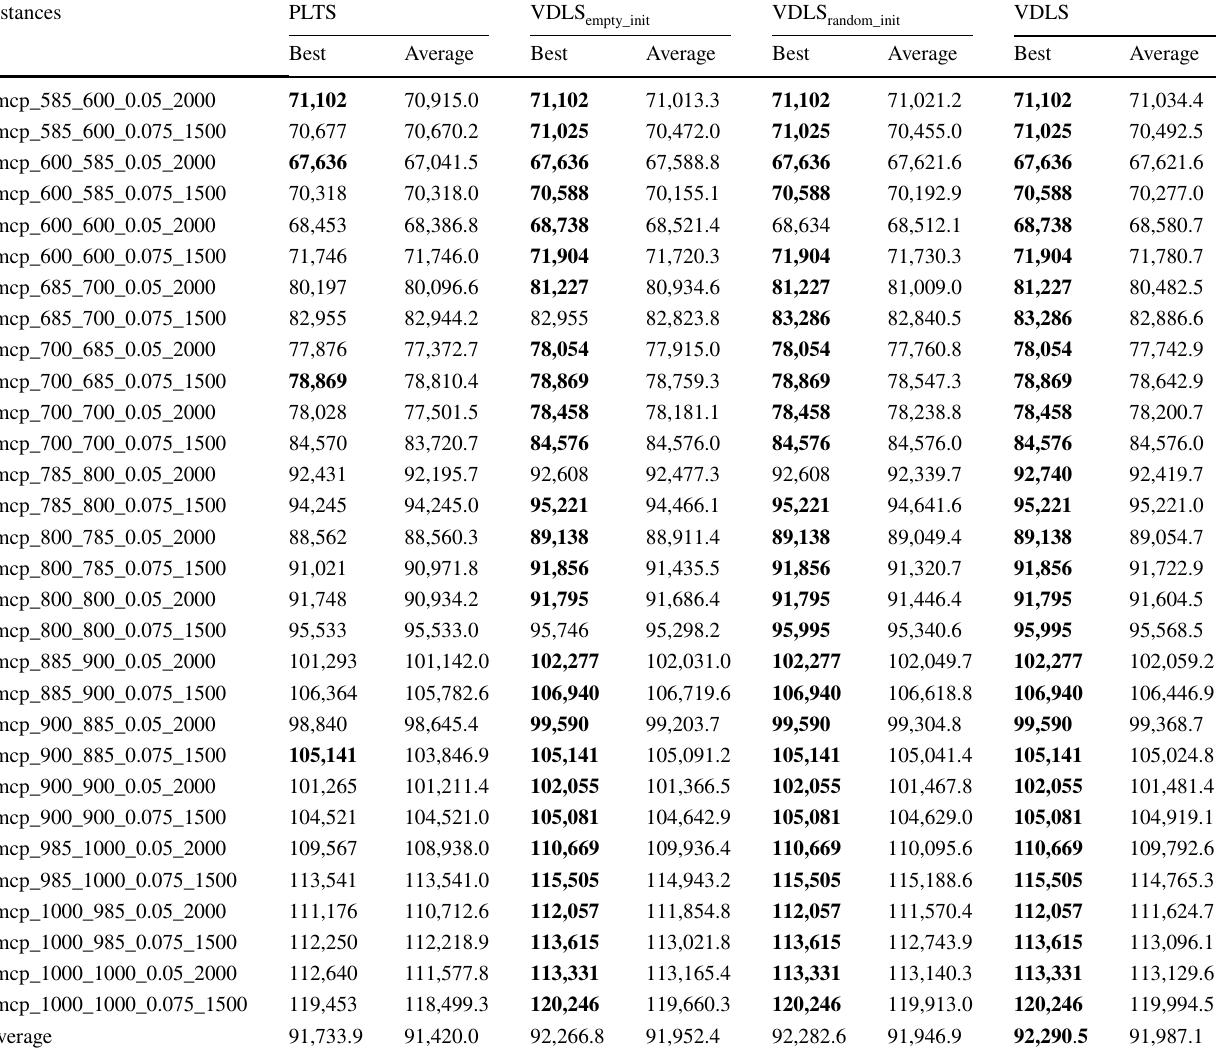
Table 9 Comparison of the VDLS and its variant algorithms, VDLS empty_init and VDLS random_init , as well as the PLTS algorithm, with 30 min of time limit in solving the 30 instances of the first set